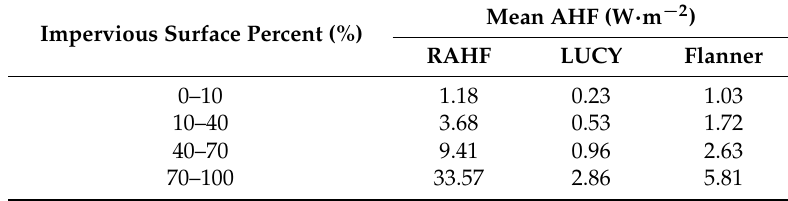
Table 6. The mean AHF of different results in different impervious surface percent (ISP)